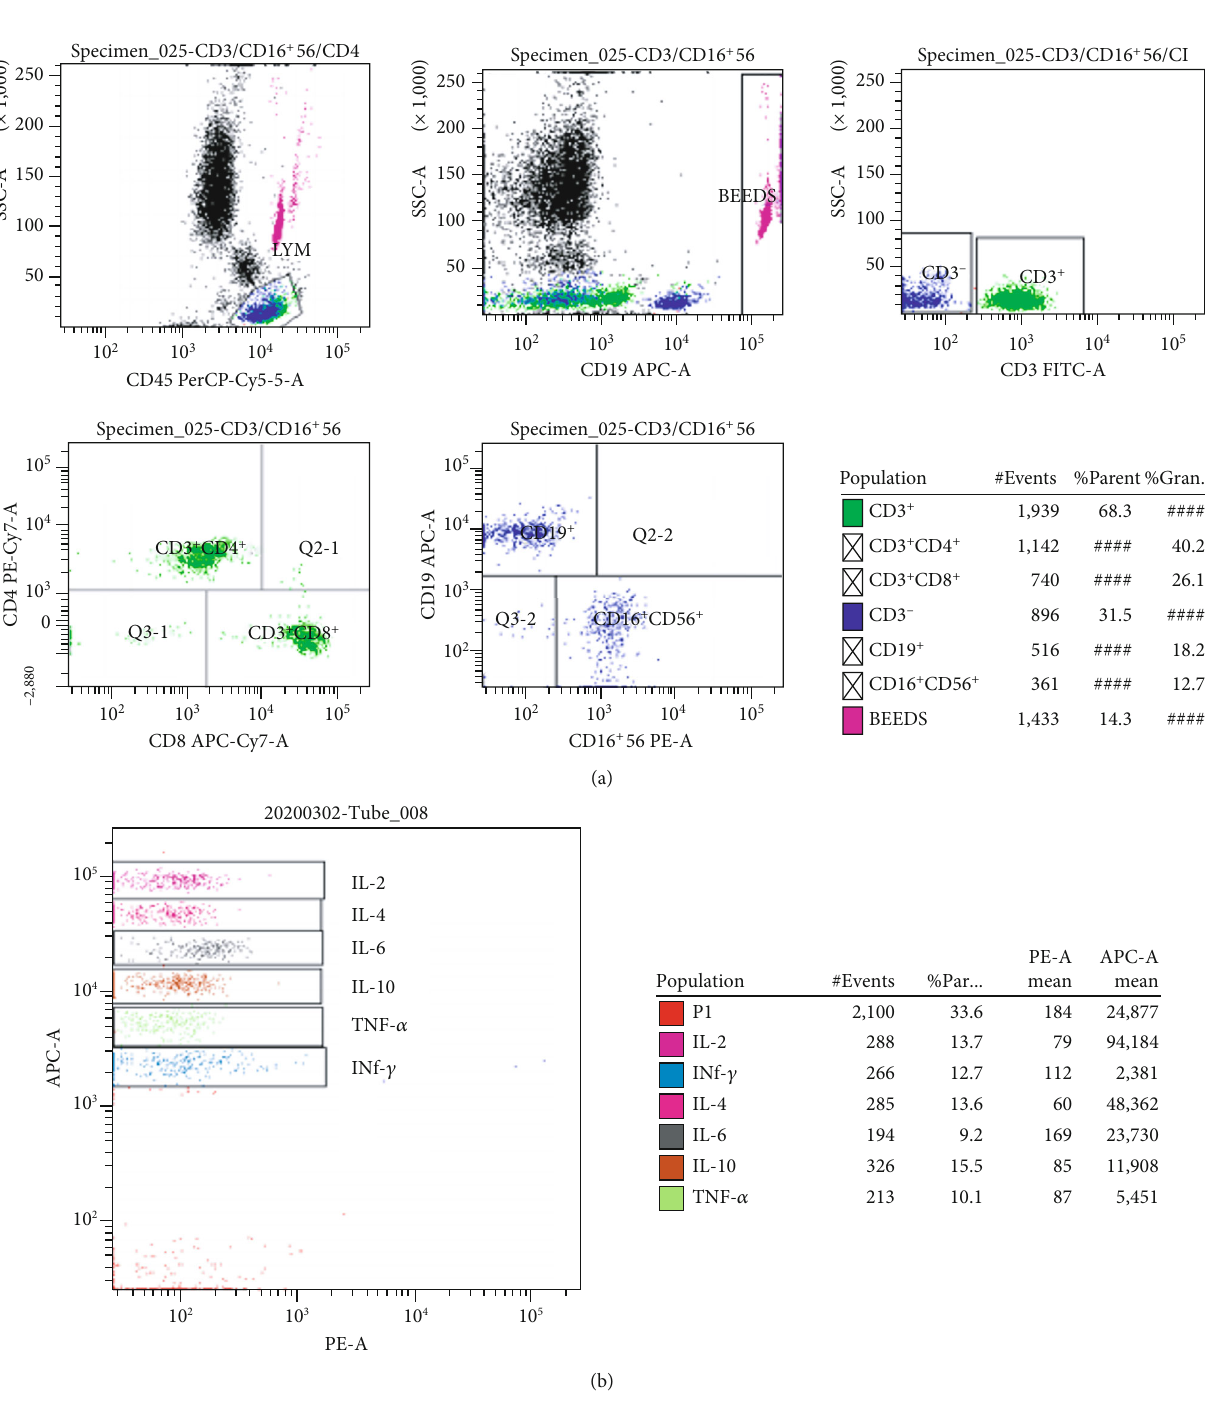
Figure 1: Flow cytometry analysis template to detect the CD3 + , CD3 + CD4 + , CD3 + CD8 + , CD19 + , and CD16 + CD56 + cells (a) and 6 kinds of cytokines (b) in one tube